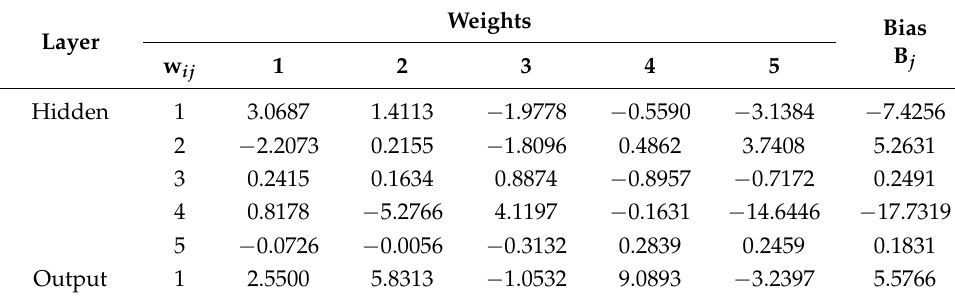
Table 5. Weights and Biases for J nr 3.2 model of unaged